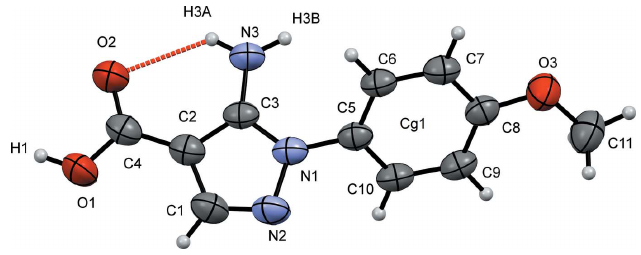
Figure 1 The molecular structure of (I) with displacement ellipsoids drawn at the 50% probability level. The intramolecular hydrogen bond is represented by a red dashed line.